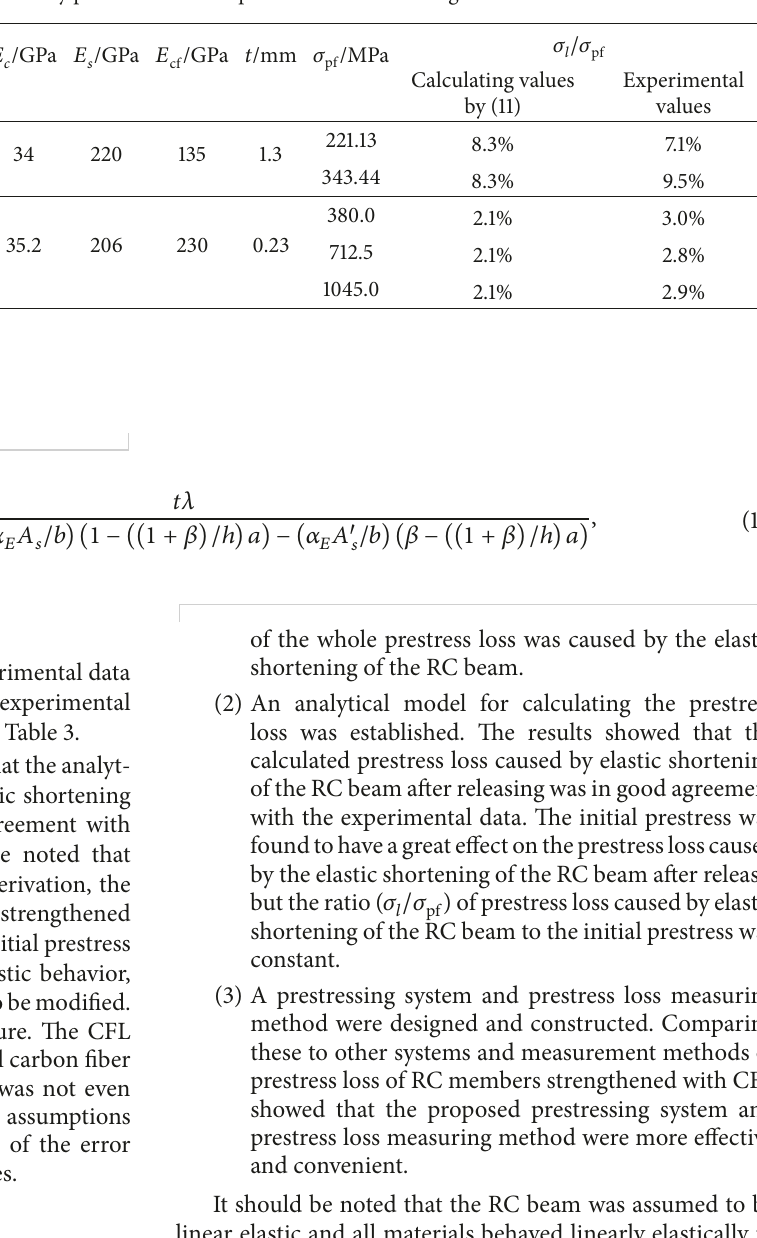
Table 3: Prestress loss by predictions and experiments after